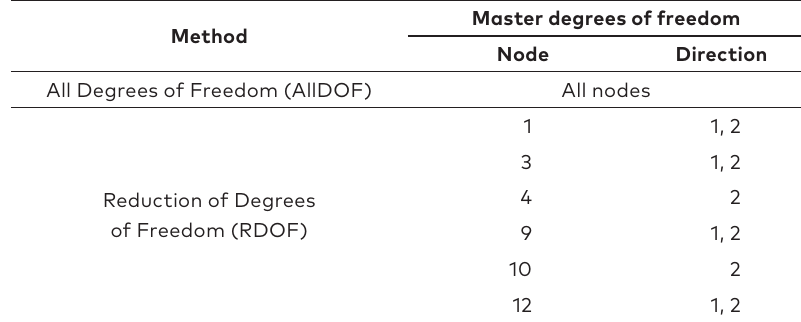
Table 5. Master degrees of freedom for a 31-element